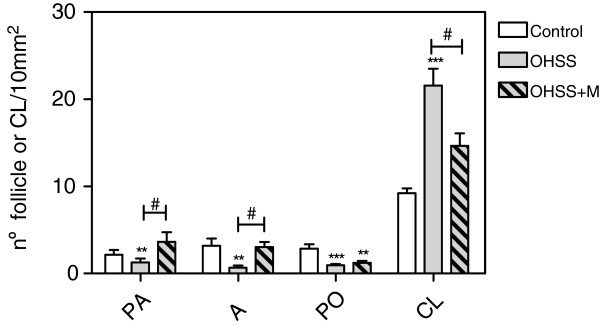
Effect of the treatment with Metformin on the ovarian morphology in an OHSS rat model. This is a quantitative morphometric analysis of the ovarian sections after Masson trichrome staining. Follicles were classified according to the stage of development indicated in materials and methods. Values are expressed as the number of follicles per 10 mm2. Data represent the mean ± S.E.M for 10 ovaries from different animals with the same treatment, and each value represents the mean of 10 sections from the same ovary. ** P< 0.01 and *** P< 0.001 respect to the control group; # P< 0.05 between the pointed groups.